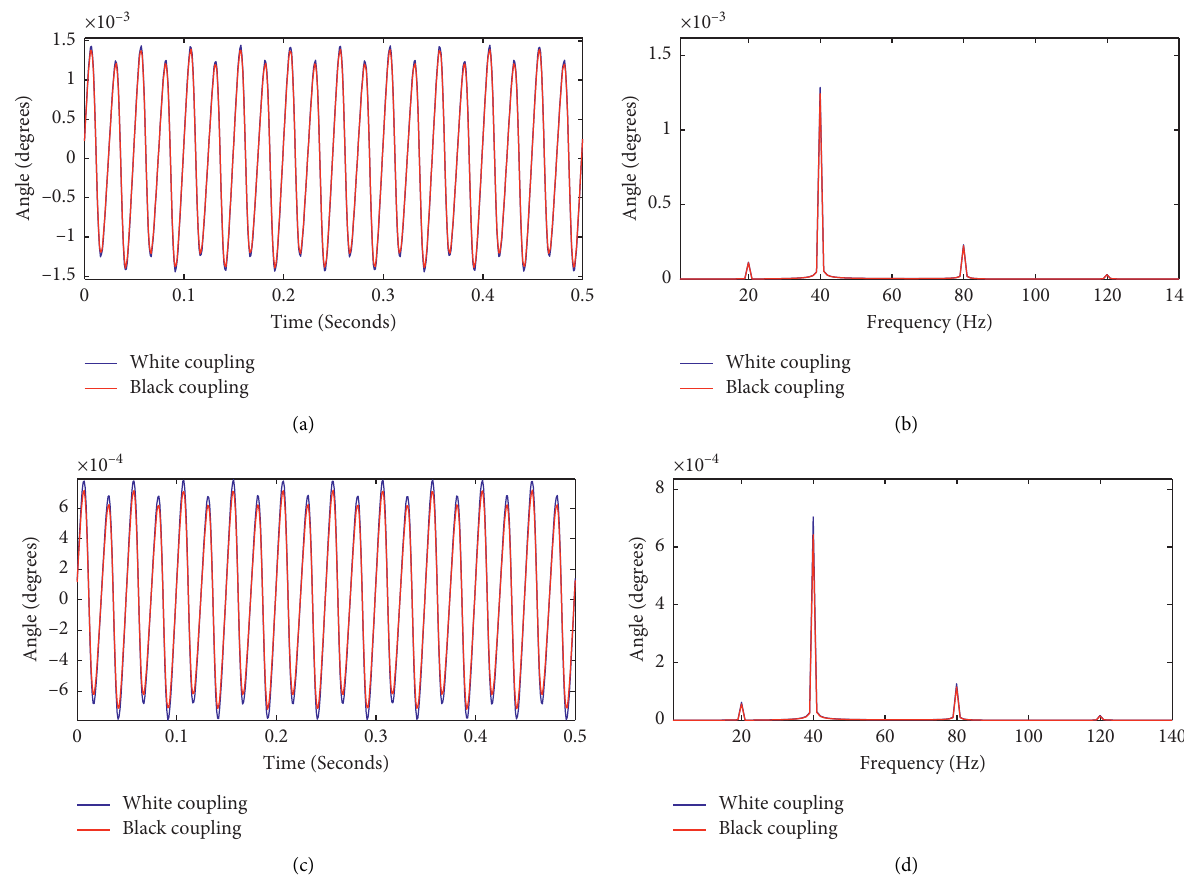
Figure 25: Effects of changing the coupling type in the θ direction for a system with imbalance and angular misalignment. (a) Time response of θ 1 . (b) Frequency response of θ 1 . (c) Time response of θ 2 . (d) Frequency response of θ 2